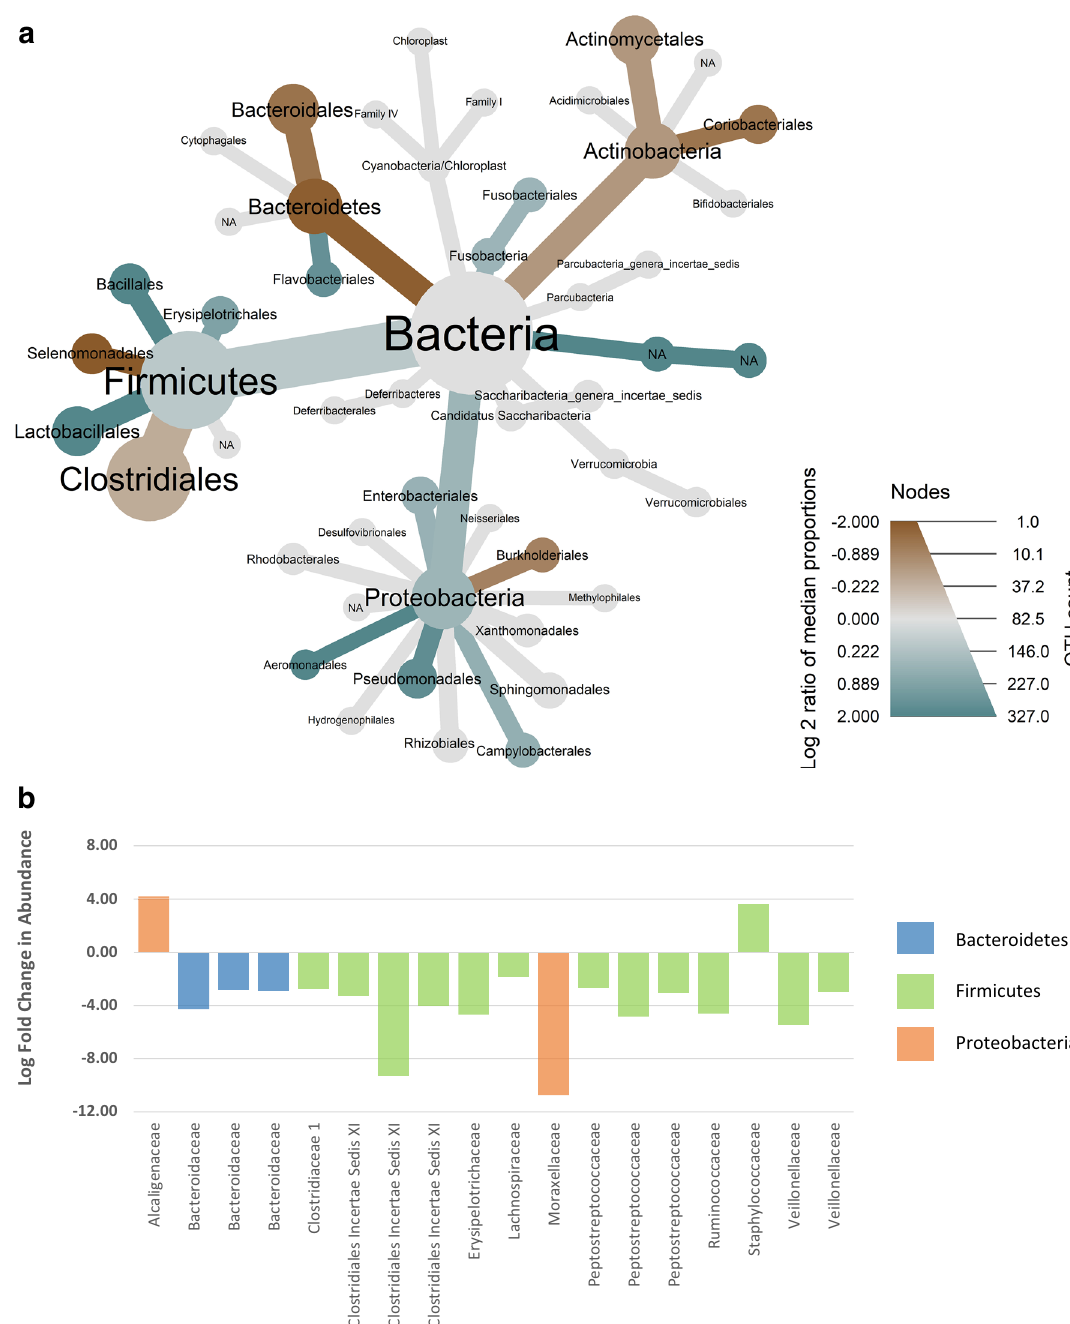
Figure 2. ( a ) Metacoder heat tree showing the log 2 ratio of median proportions for bacterial taxa in polar bears demonstrating mercury concentrations above, compared to below, the 6.0 g g –1 dw no observed effect level (NOEL) threshold for humans. Nodes are weighted by OTU count and coloured on a gradient from largest decrease in median proportion (teal) to largest increase in median proportion (tan). ( b ) Differential OTU abundance from DESeq2 analysis of polar bears demonstrating mercury levels above, compared to below, NOEL threshold for humans. OTU are plotted at family level with associated phyla